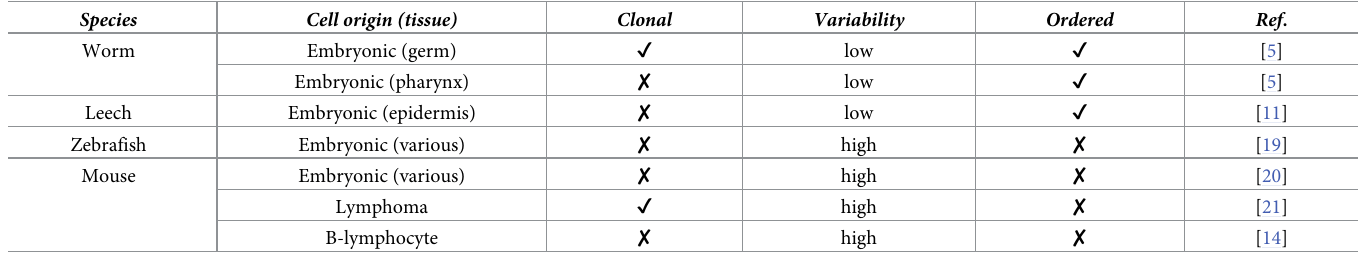
Table 1. Characteristics of some cell lineage patterns. Organisms are listed in order of increasing complexity. Lineages are characterized in terms of whether cell fate is exclusive to a subclone, the degree of phenotypic variability, and whether the lineage tree measurement is ordered. Lineages from higher organisms are generally unor- dered, have high variability, and may or may not be